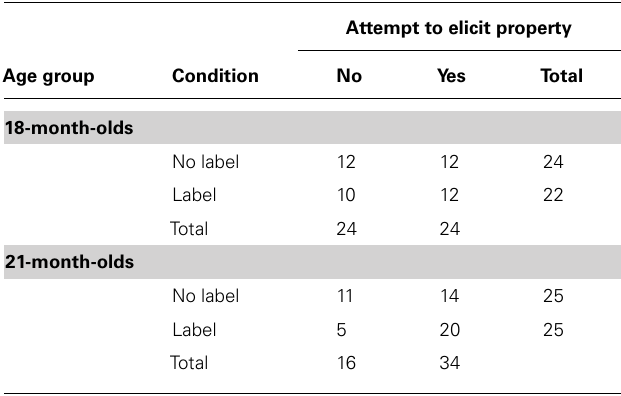
Table 3 | Generalization trial: Learning as a function of condition and Table 5 | Predictors of test performance on the extension age group. Attempt to elicit property